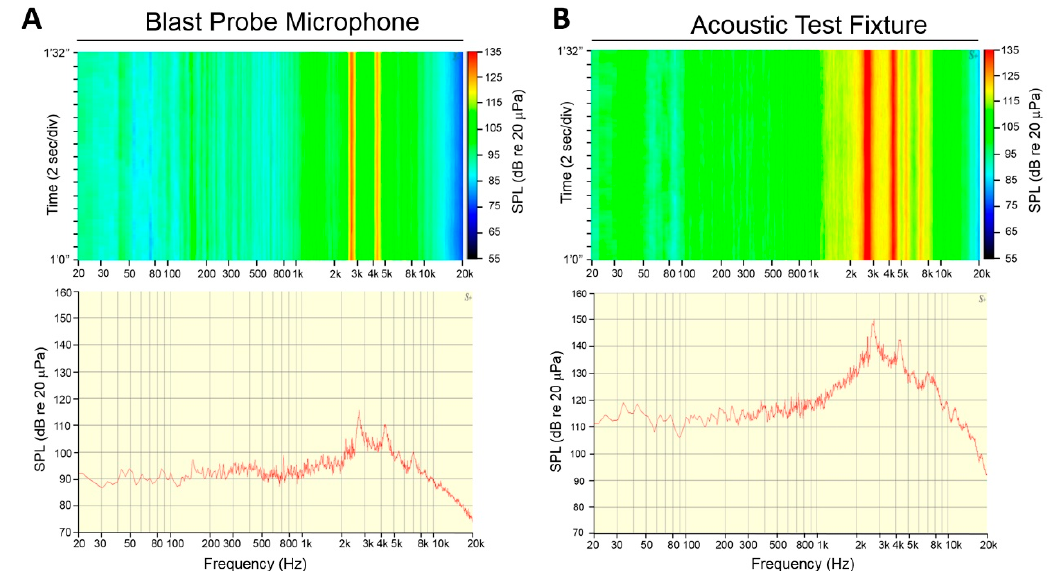
Figure 6. Spectrogram and power spectrum of the noise inside the hardened aircraft shelter for 32 s, collected by ( A ) the blast probe microphone (GRAS 67SB) and ( B ) the acoustic test fixture (GRAS 45CB). SPL = sound pressure level.